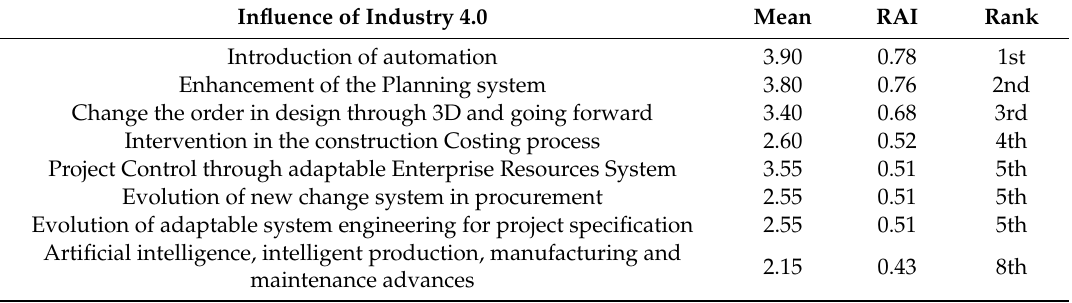
Table6. InfluenceofIndustry4.0andleanthinkinginTechnologicalDevelopmentforConstructionIndustry. Influence of Industry 4.0 Mean